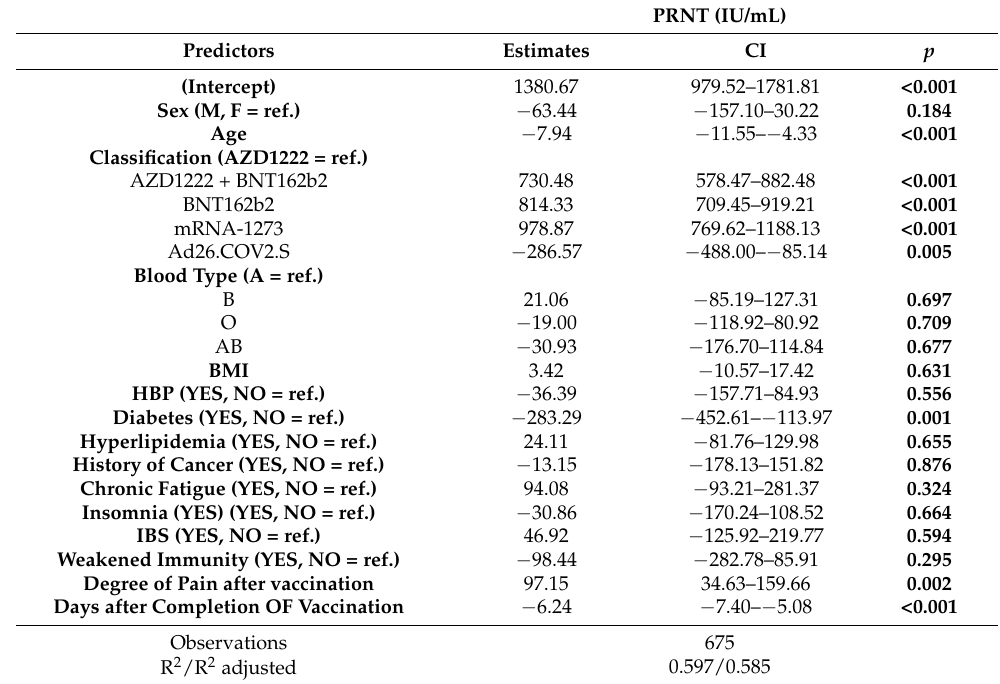
Table 4. Multiple regression analysis of various factors according to neutralizing antibody